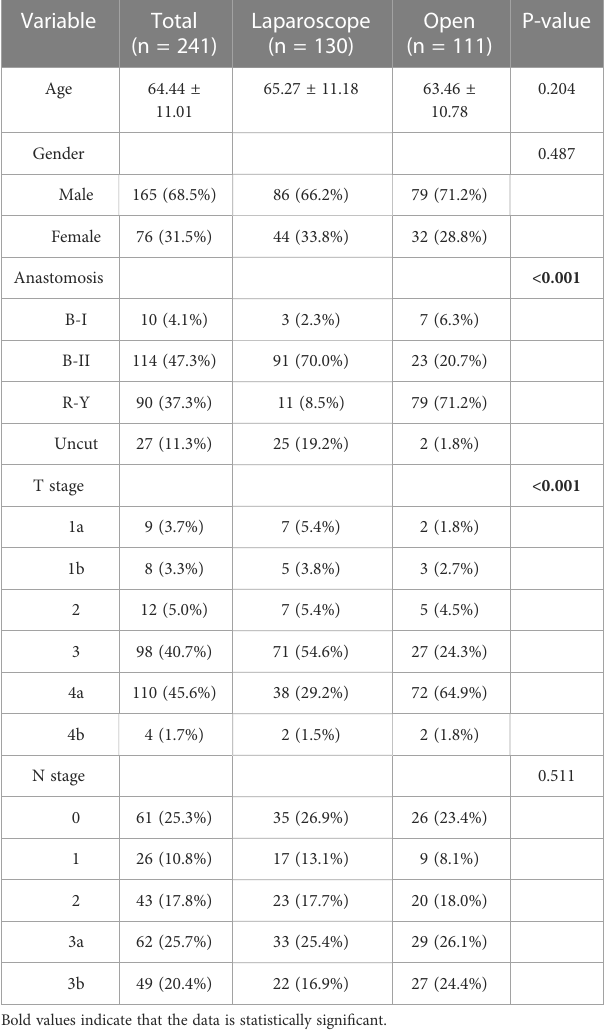
TABLE 1 Basic characteristics of gastric cancer (GC) patients with pyloric outlet obstruction (POO). Variable